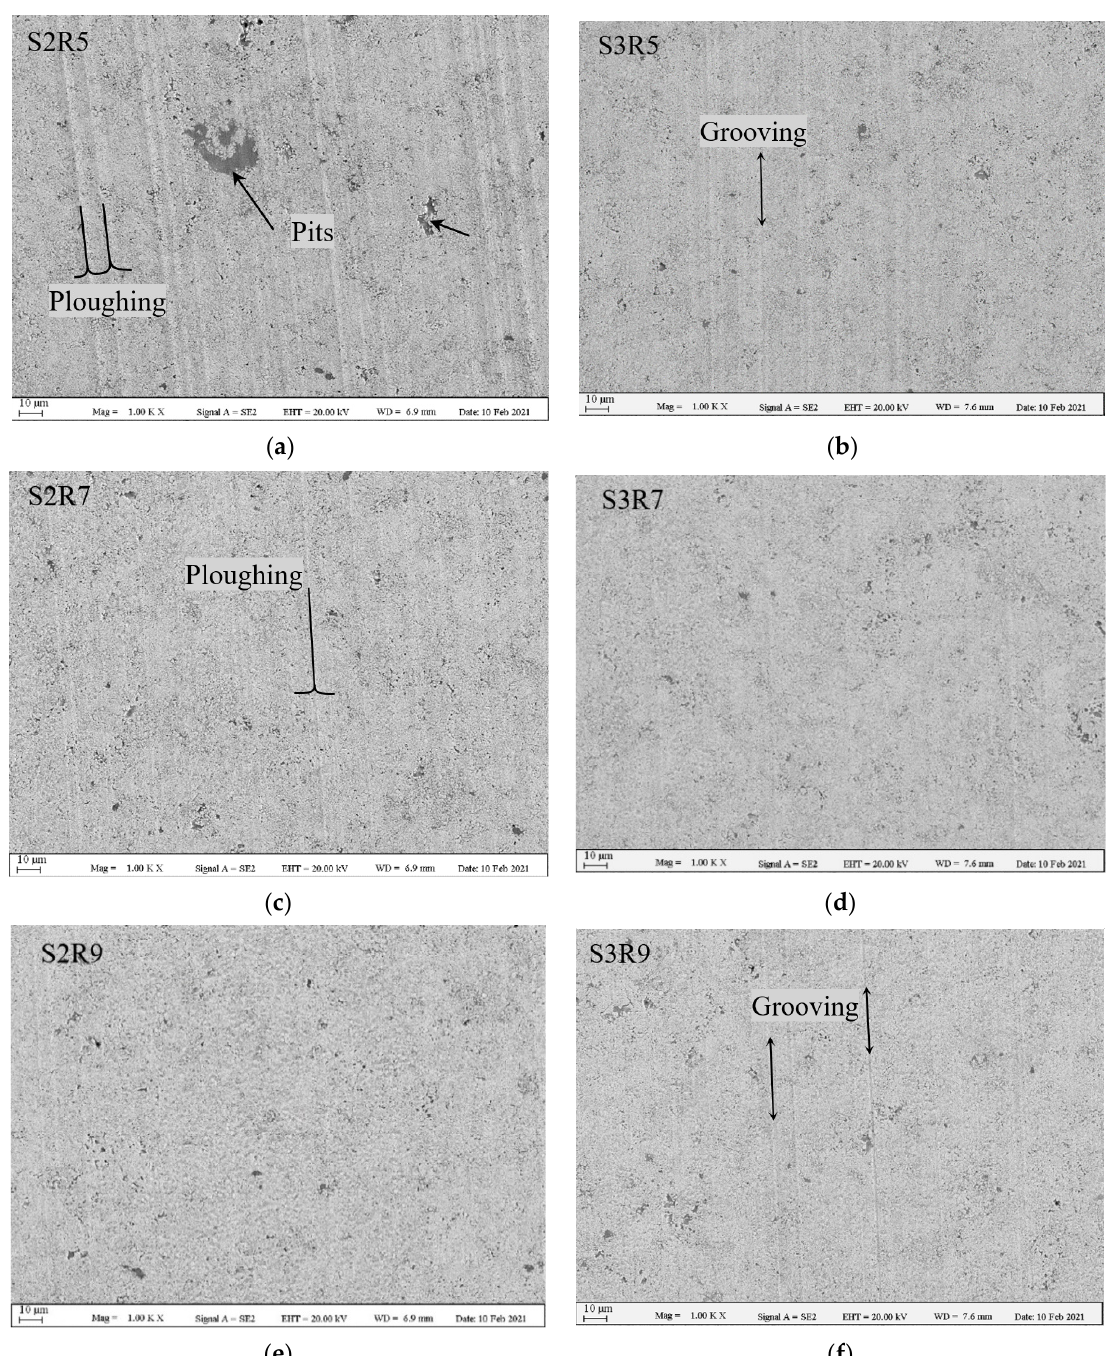
Figure 6. SEM images of wear tracks at different radii of 5, 7 and 9 mm. ( a ) S2R5; ( b ) S3R5; ( c ) S2R7; ( d ) S3R7; ( e ) S2R9 and ( f ) S3R9.